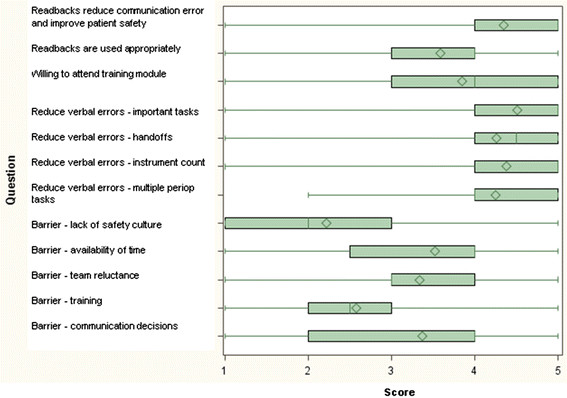
Box plot depicting the overall survey results. The length of the box represents the interquartile range (the distance between the 25th and 75th percentiles). The diamond in the box interior represents the mean score. The horizontal line in the box interior represents the median score. The vertical lines (whiskers) issuing from the box extend to the minimum and maximum value.